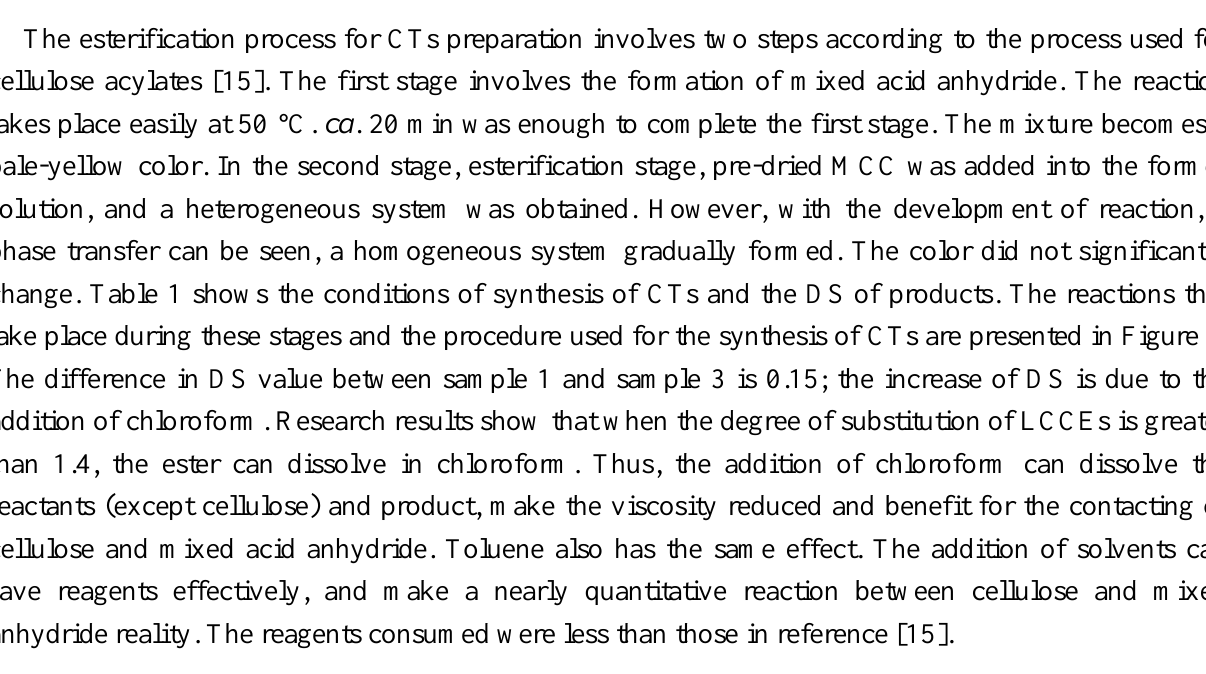
Figure 1. Synthetic route to cellulose